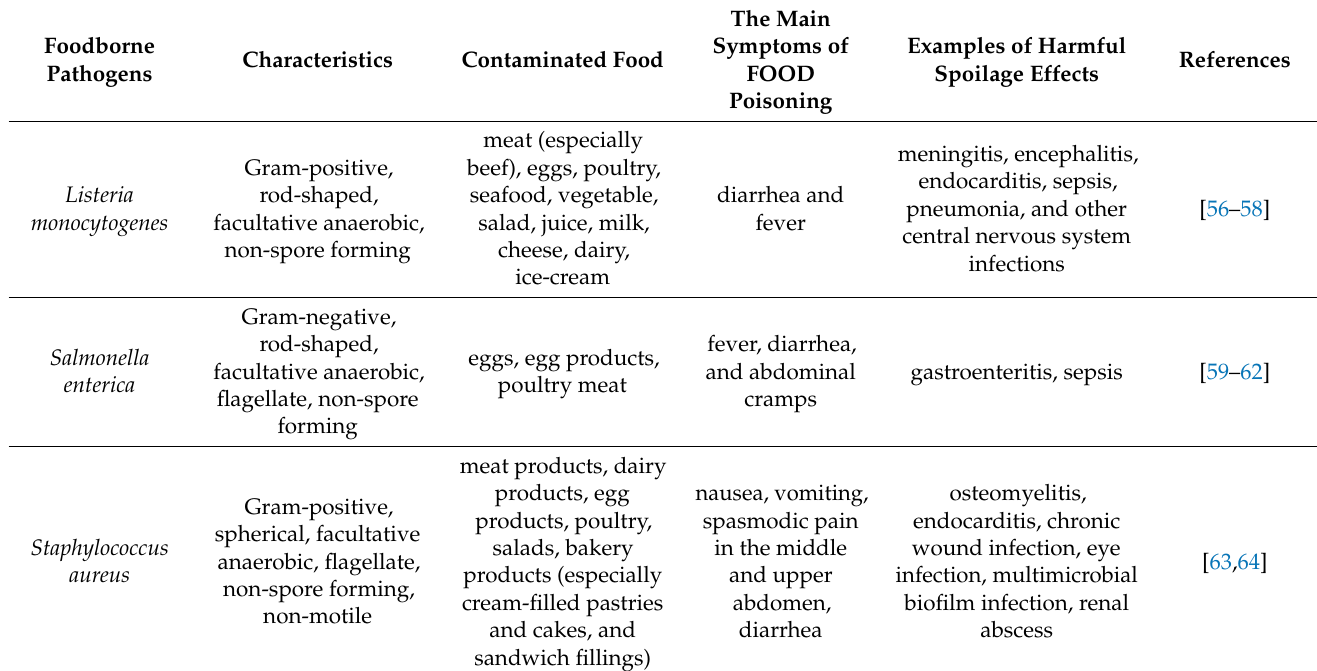
Table 3. A summary of common foodborne pathogens and their implications for food